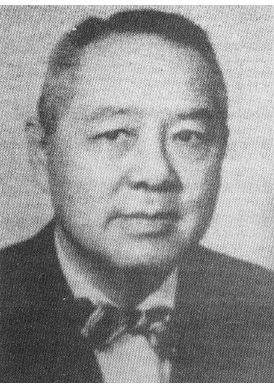
Figure 1. Robert Kho-Seng Lim (1897 – 1969).